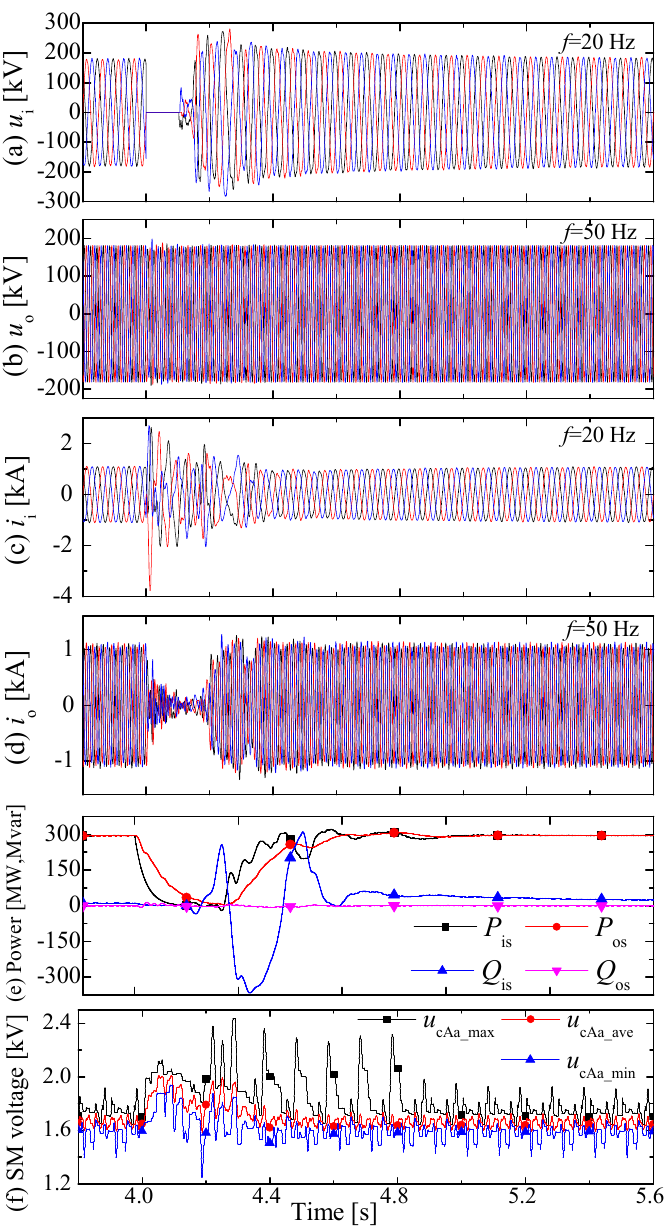
Figure 13. System responses to the offshore side fault: ( a ) voltage on input side; ( b ) voltage on output side; ( c ) current on input side; ( d ) current on output side; ( e ) input and output powers; and ( f ) instantaneous maximum, average, and minimum values of SM capacitor voltages in arm Aa.